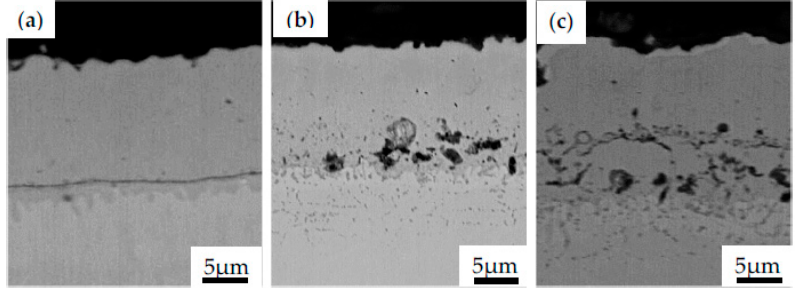
Figure 6. The microstructural evolution of the NiAl coating obtained during CVD process in the as-received state ( a ) and subjected to high temperature at 1000 °C for 1 h ( b ) and 25 h ( c ).